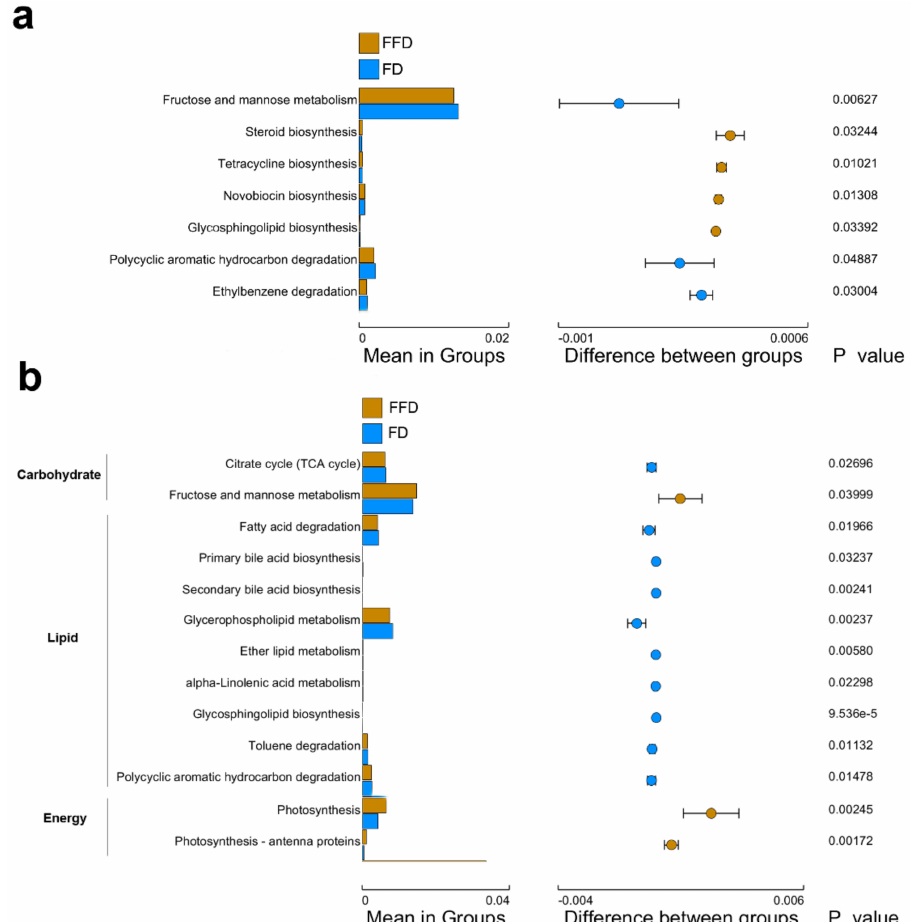
Figure 6. Significantly di ff erent metabolism pathways between FFD and FD in ( a ) sediment and ( b ) water